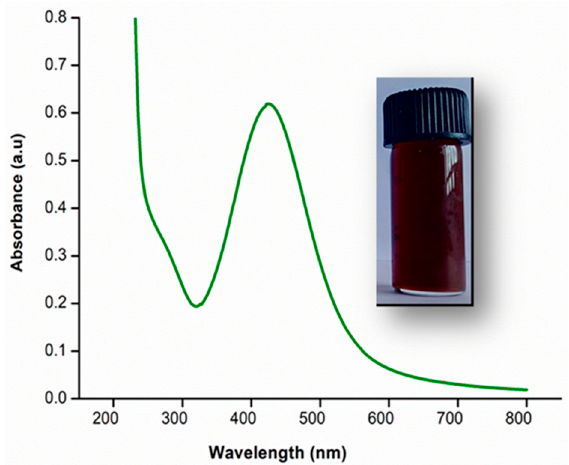
Figure 1. UV–Visible spectral analysis of green synthesized AgNPs.